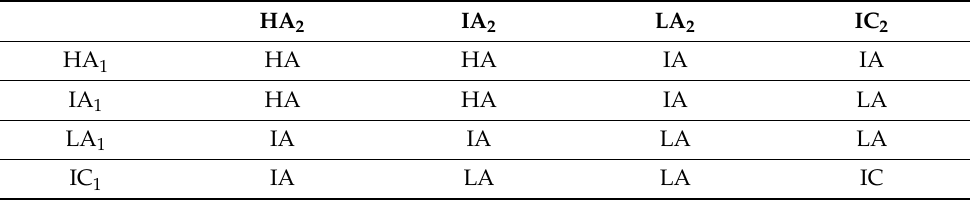
Table A4. The fuzzy rule table when u 3 is HA 3